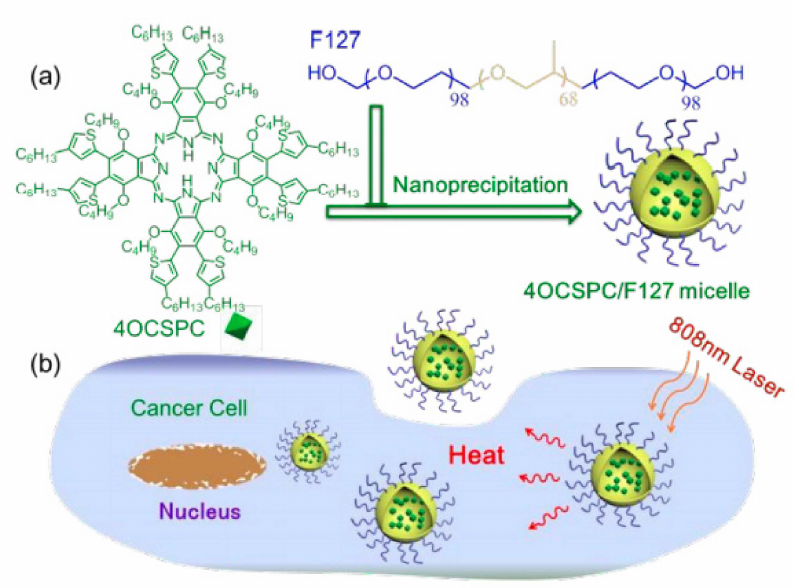
Scheme 9. Schematic illustration of the 4OCSPC-based micelle for PTT. ( a ) The structure of 4OCSPC and preparation of 4OCSPC/F127 micelle. ( b ). PTT action the new micelles. Reprinted with permission from ref [64]. Copyright 2019 The Royal Society of